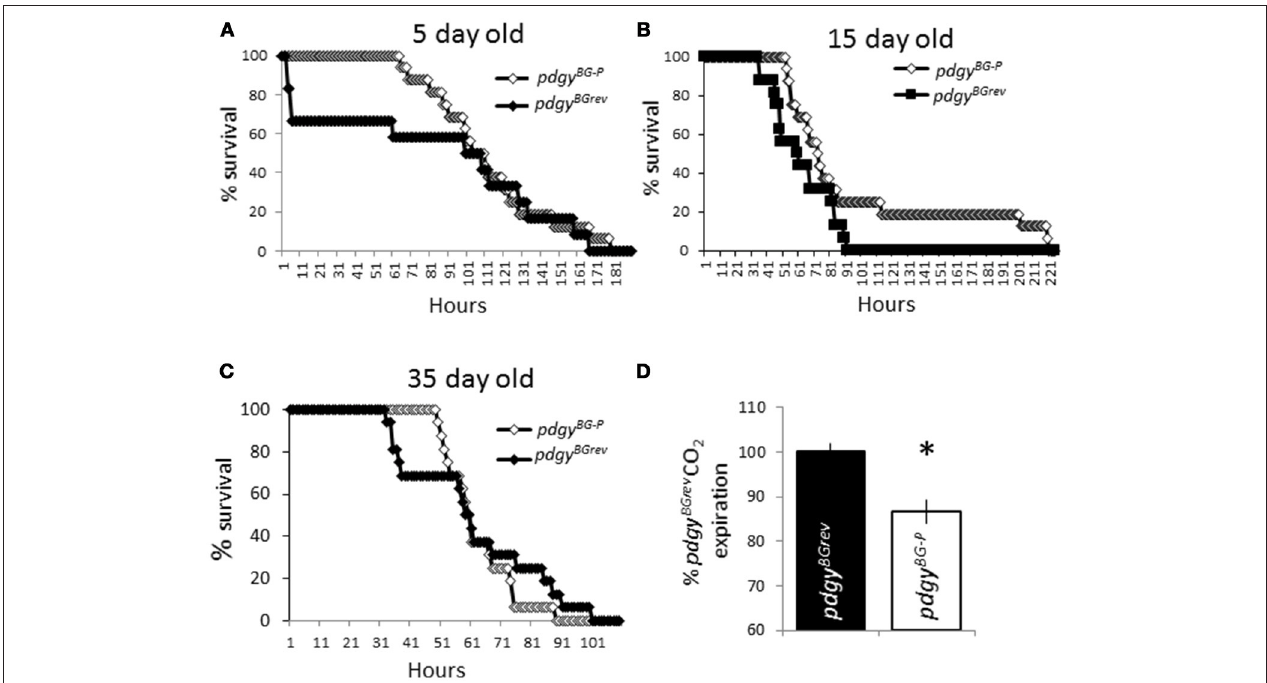
FIGURE 5 | Pdgy mutants are not generally unfit flies. pdgy BG − P and pdgy BGrev were put on peroxide in their food different ages, 5 d.o. (A) , 15 d.o. (B) , and 35 d.o. (C) . n = 16 for each condition. (D) We measured levels of CO 2 expired as an indicator of respiration. Levels of CO 2 are displayed as percent of control. * p <